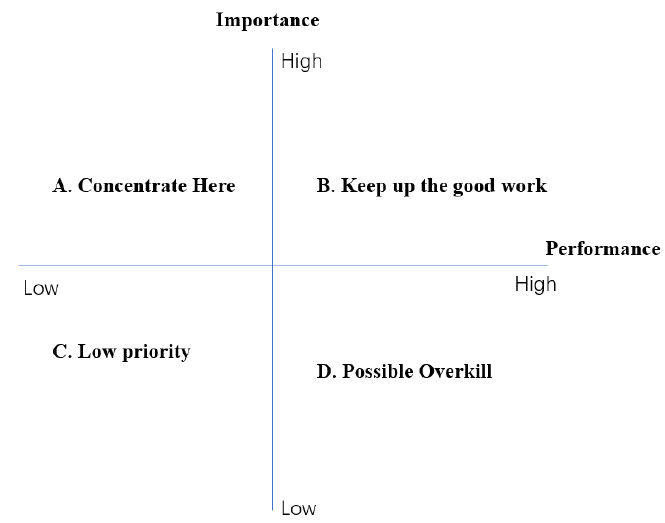
Figure 1. Importance–performance analysis grid.